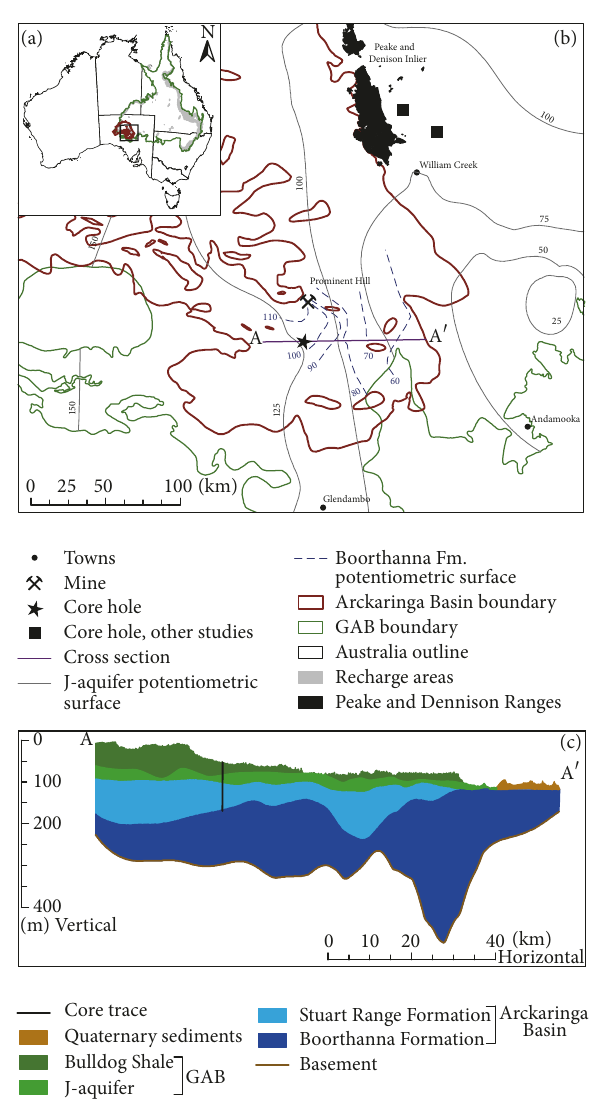
Figure 1: (a) Study location in the GAB and Arckaringa Basin in central Australia, also showing main recharge areas. (b) Location of core from this study as well as those from Gardner et al. [46] and Harrington et al. [24]. Groundwater potentiometric surfaces included with water level in m AHD. (c) Cross section showing stratigraphy and depth of the